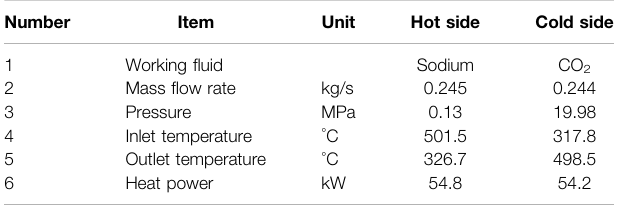
TABLE 1 | Test results under rated condition.